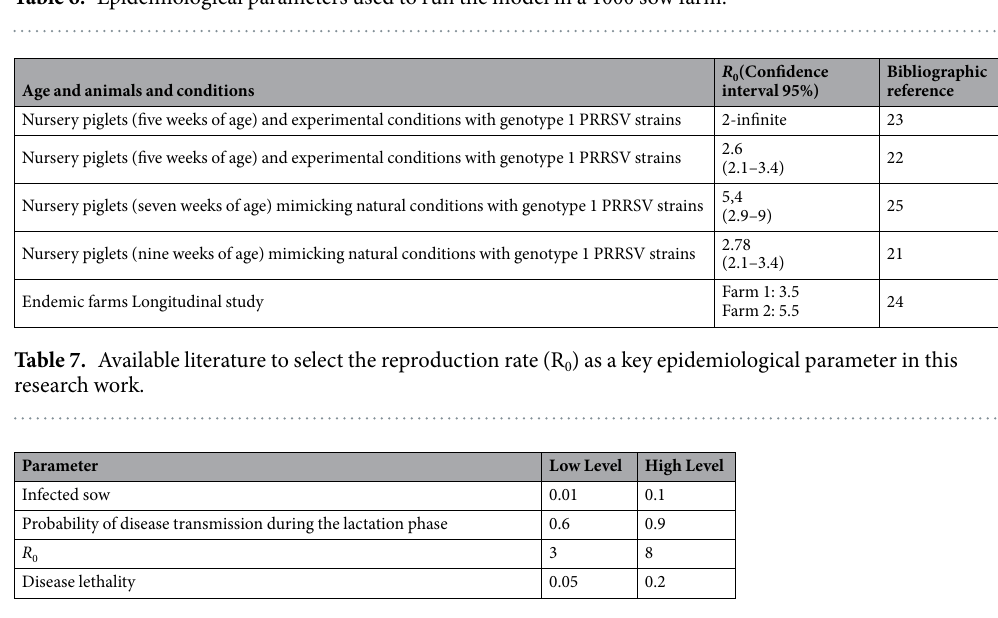
Table 8. Range of values for the percentage of infected sows, the probability of disease transmission during the lactation phase, reproduction rate ( R 0 ) and disease lethality to carry out the uncertainty and sensitivity